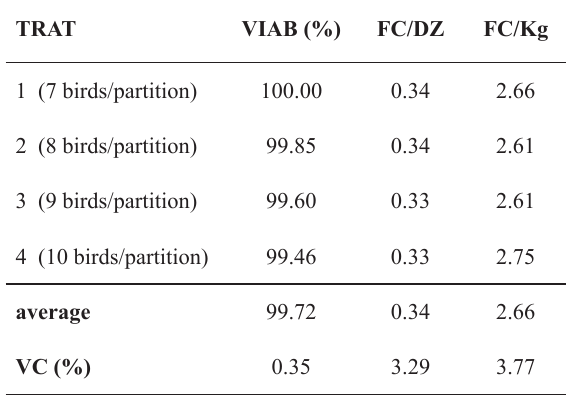
Density effect on viability (VIAB), feed conversion per dozen eggs ( FC/DZ) and feed conversion per kilo (FC/Kg).